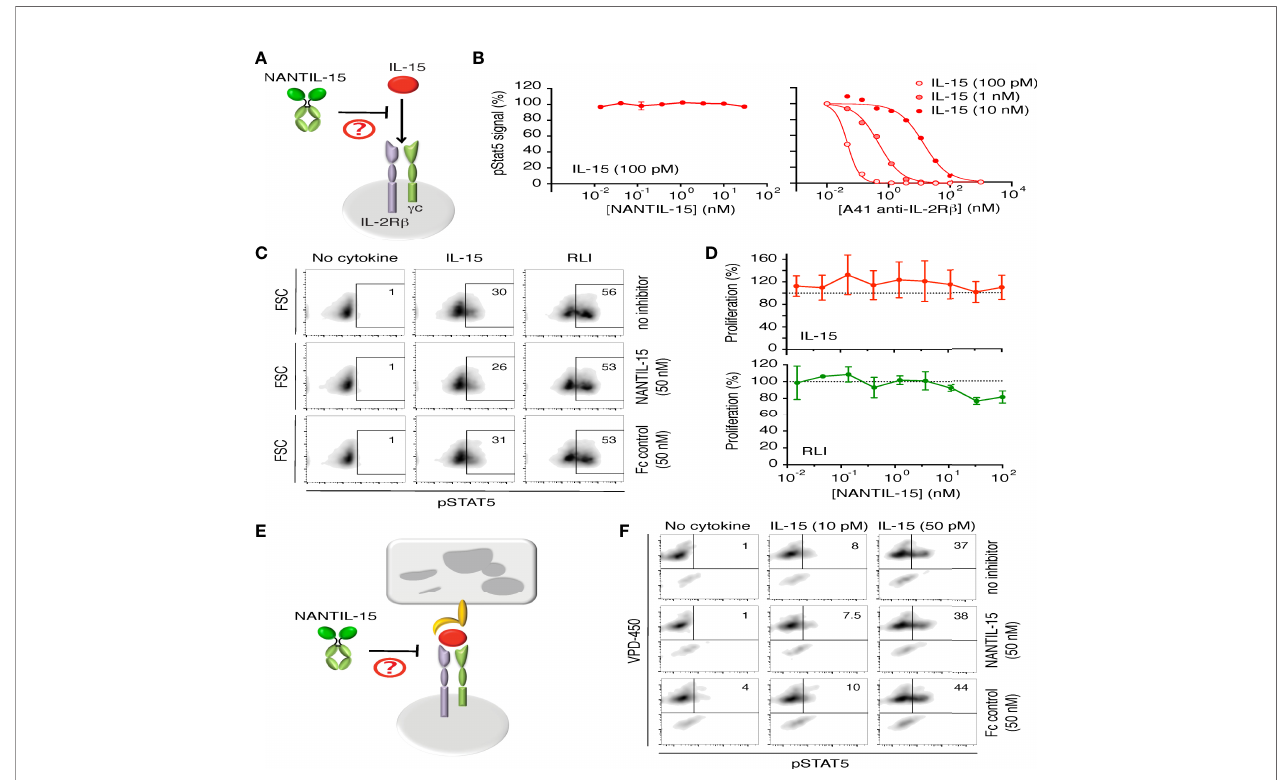
FIGURE 2 | NANTIL-15 does not affect IL-15 ’ s signaling through dimeric IL-2R b / g c receptor. (A) Diagram showing NANTIL-15 acting on the signaling of IL-15 through the dimeric IL-2R b / g c receptor. (B) Left panel: Effect of increasing concentrations of NANTIL-15 on IL-15 (100 pM)-induced Stat5 phosphorylation within Kit225-15R a KO cells by AlphaScreen. Right panel: Inhibition of IL-15 (100 pM, 1 nM, and 10 nM)-induced Stat5 phosphorylation within Kit225-15R a KO cells by increasing concentrations of blocking A41 anti-IL-2R b antibody by AlphaScreen. (C) Effect of NANTIL-15 or Fc control on IL-15 (50 pM)- or RLI (100 pM)-induced Stat5 phosphorylation within Kit225-15R a KO cells by fl ow cytometry. Number indicated the percentage of pStat5 positive cells. (D) Proliferation of Kit225-15R a KO cells in response to fi xed concentrations of IL-15 (upper panel) or RLI (lower panel) in the presence of increasing concentrations of NANTIL-15. (E) Diagram showing NANTIL-15 acting on IL-15 trans -presentation. (F) Flow cytometric analysis of pStat5 expression within VPD-450 labeled Kit225 responding cells following 1 h coculture with wt.IL-15R a HEK-293 expressing cells loaded with IL-15 (10 or 50 pM) in the presence or the absence of NANTIL-15 (50 nM). Number indicated the percentage of pStat5-positive cells. All data are representative of at least three separate